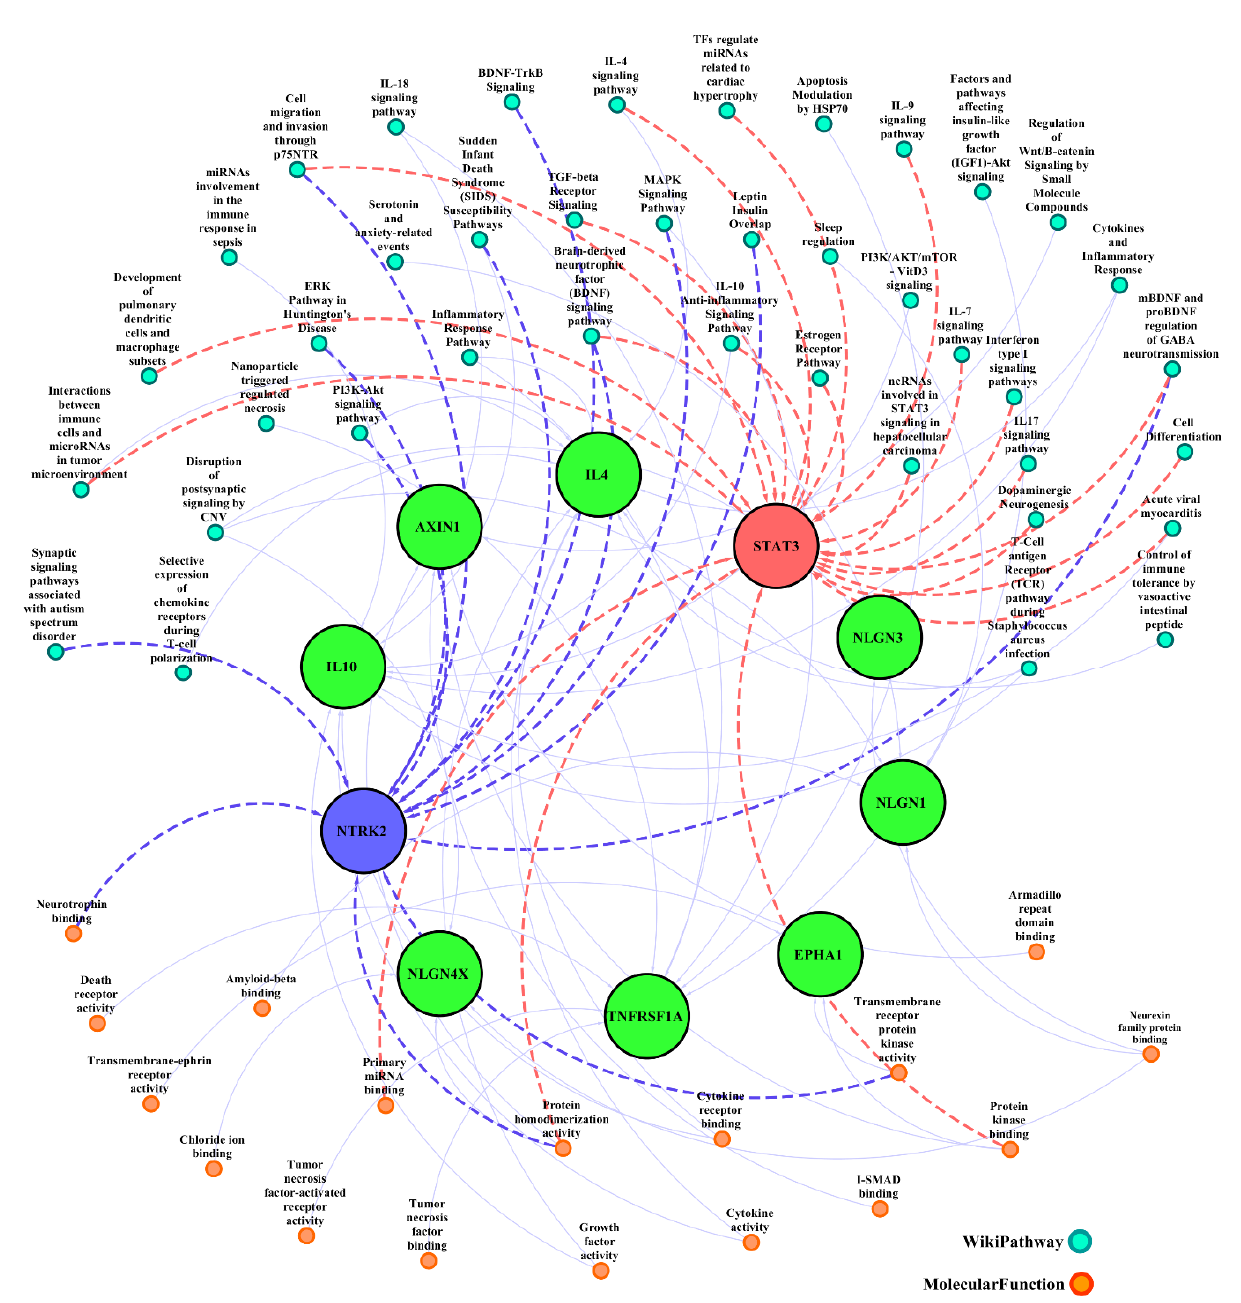
Figure 4. Molecular and pathway genetic network of 10 predicted novel genes for MS and OCD. Central big nodes indicated 10 predicted novel genes for MS and OCD. Peripheral orange nodes represented all enriched molecular functions and turquoise nodes specified main involved pathways for 10 central novel genes. STAT3 and NTRK2 are two important genes with the highest degree (more connected) in the network and annotated most of the enrichments. All enriched categories are connected to their target genes and are annotated as enrichment p -value less than 0.05.